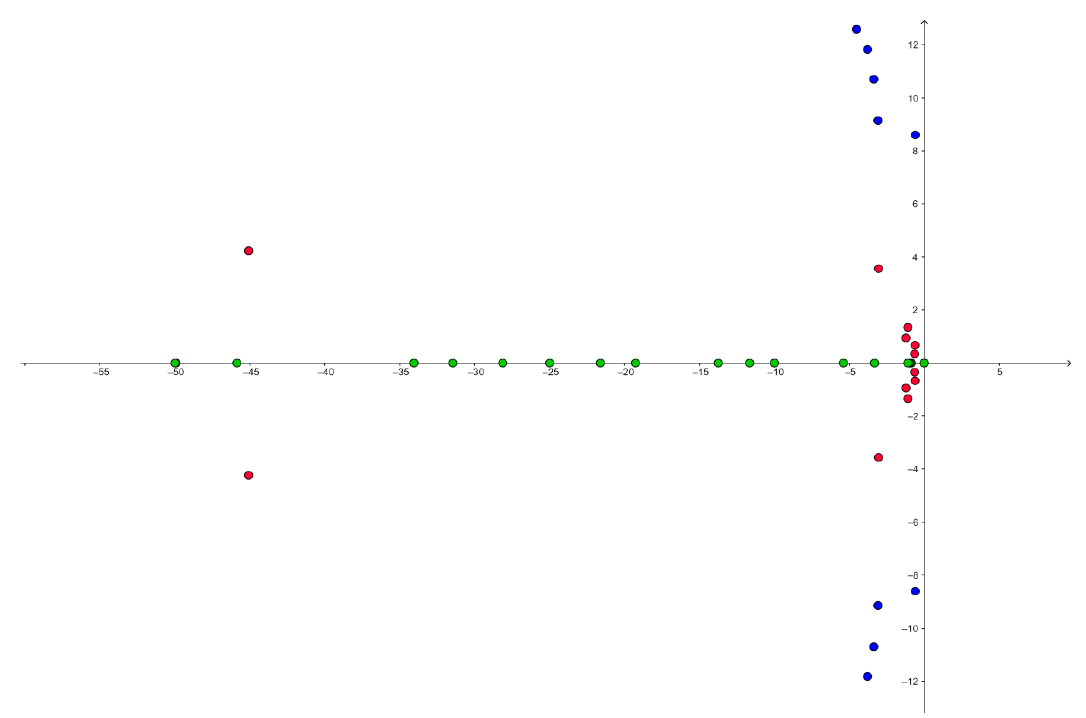
Figure 5. Root locus diagram of the analyzed system without the PSS implementation. Table 2. Participation of the generator speed state variable for the dominant oscillatory